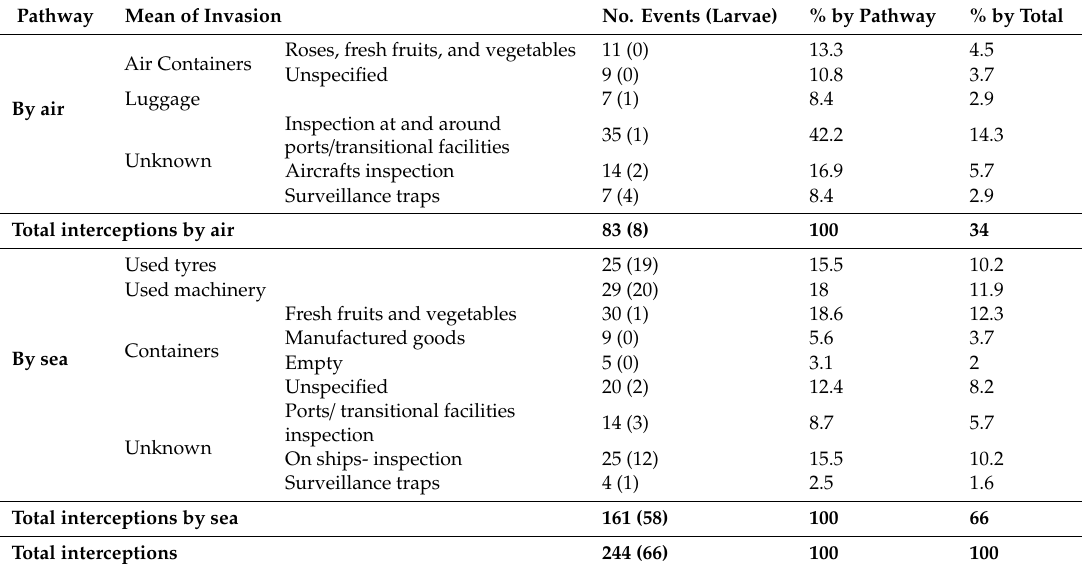
Table 5. Mosquito interception events in New Zealand, July 2001–March 2018.